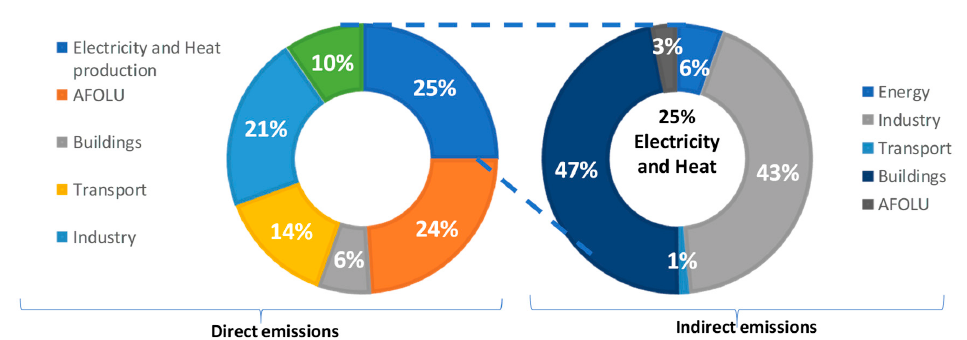
Figure 1. World emissions of greenhouse-effect gases (GHG) by economic sectors [2]. Definition of AFOLU: Agriculture, Forestry and Other Land Use.